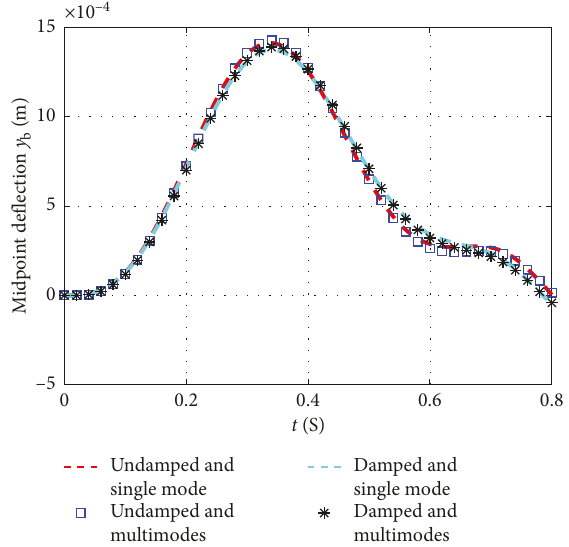
Figure 5: Effect of damping and modes on midspan vertical